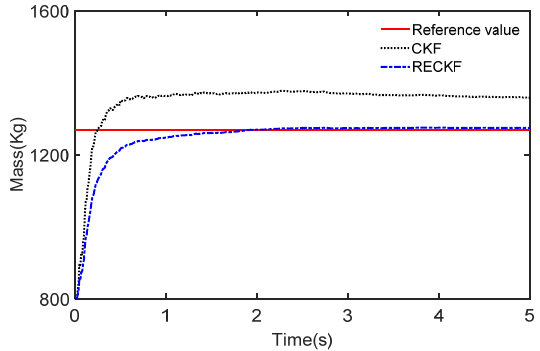
Figure 7. The estimated mass in the case of acceleration.